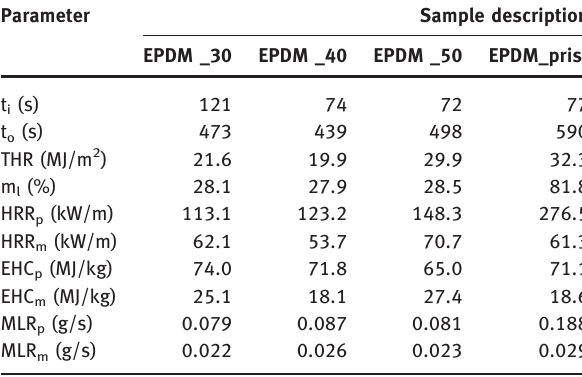
Table 6: Combustibility parameters of samples studied: time to ignition (ti), time to flameout (to), total heat release (THR), mass loss (ml), heat release rate peak (HRRp) and its mean value (HRRm), effective heat of combustion peak (EHCp) and its mean value (EHCm), mass loss rate peak (MLRp) and its mean value (MLRm).